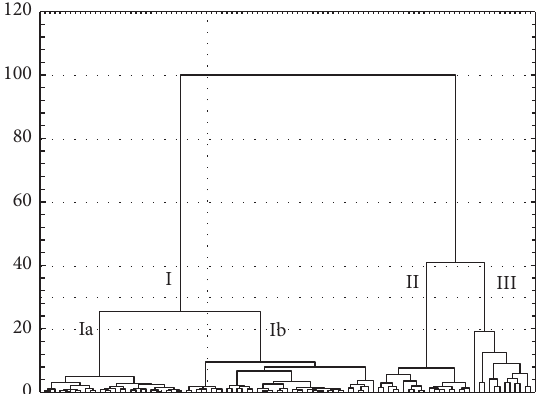
Figure 1: HCA dendrogram illustrating the clustering of ninety seven patients under antidepressant